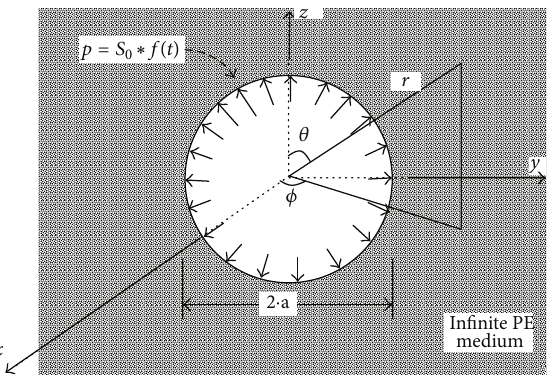
Figure 1: Description of problem, pressurized spherical cavity in infinite poroelastic